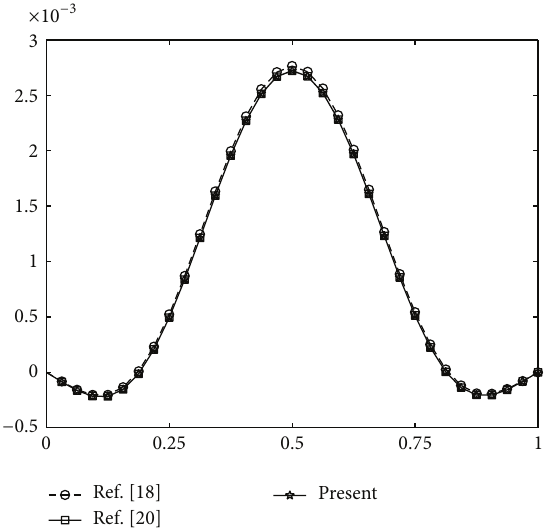
Figure 3: Numerical solutions at 𝑡 = 10 , ℎ = 1/32 , 𝜏 = 0.1 , 𝛽 = 1 , 𝛼 = 4 , and 𝑝 = 4